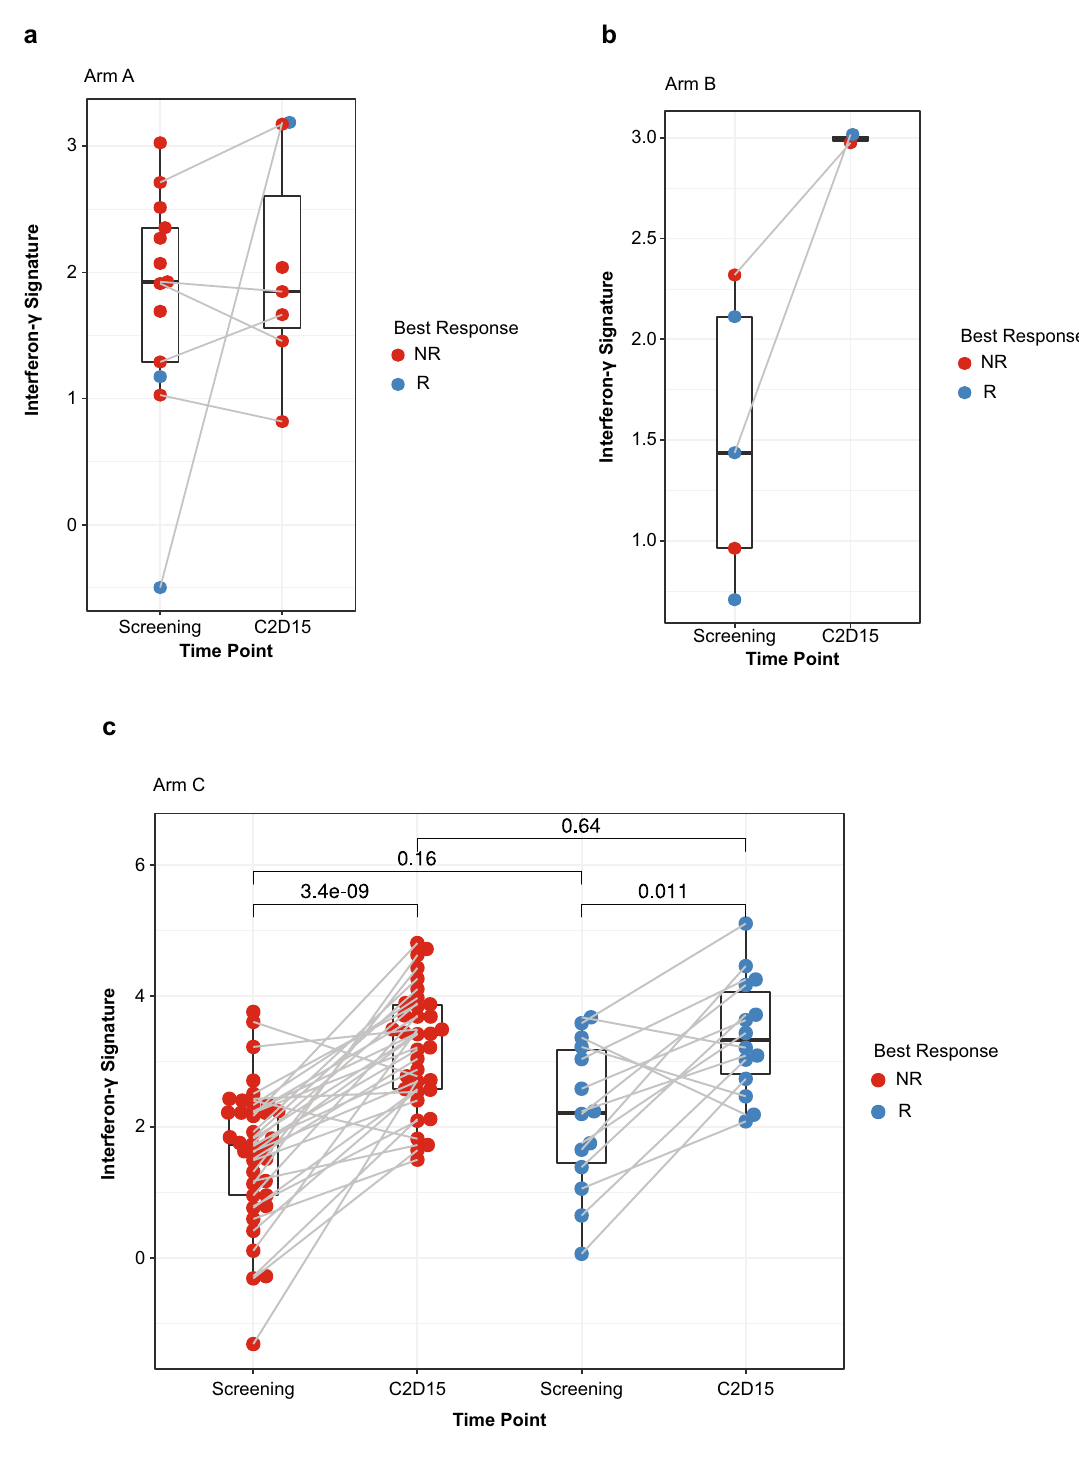
Figure 5. Normalized IFN-γ 4-gene signature in bone marrow samples of responders and nonresponders at screening and C2D15 treated with: ( a ) durvalumab monotherapy (screening n = 13; C2D15 n = 7); ( b ) durvalumab + pomalidomide (screening n = 5; C2D15 n = 2); ( c ) durvalumab + pomalidomide + dexamethasone (screening n = 51; C2D15 n = 49). Patients without a best response are excluded. C2D15, cycle 2 day 15; IFN, interferon; NR, nonresponder; R,